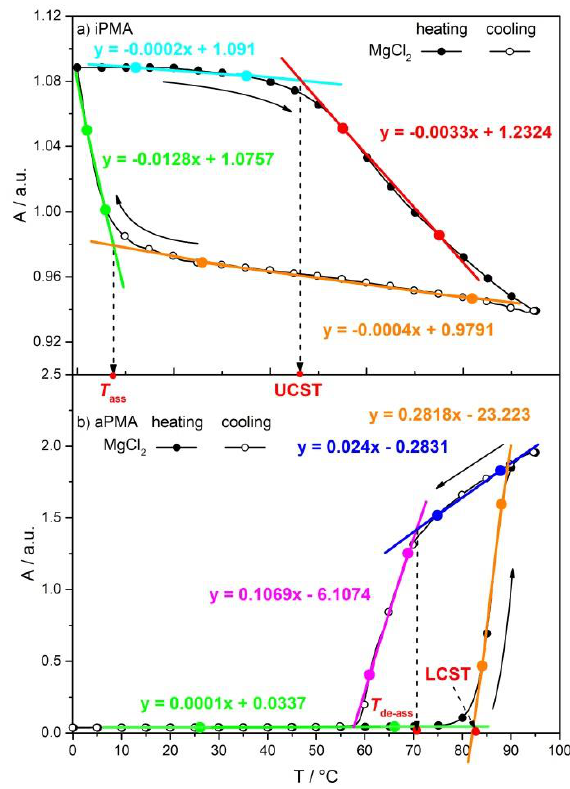
Figure S2. The method of determination of a) UCST for iPMA in MgCl aPMA in MgCl with I = 0.1 mol L -1 2